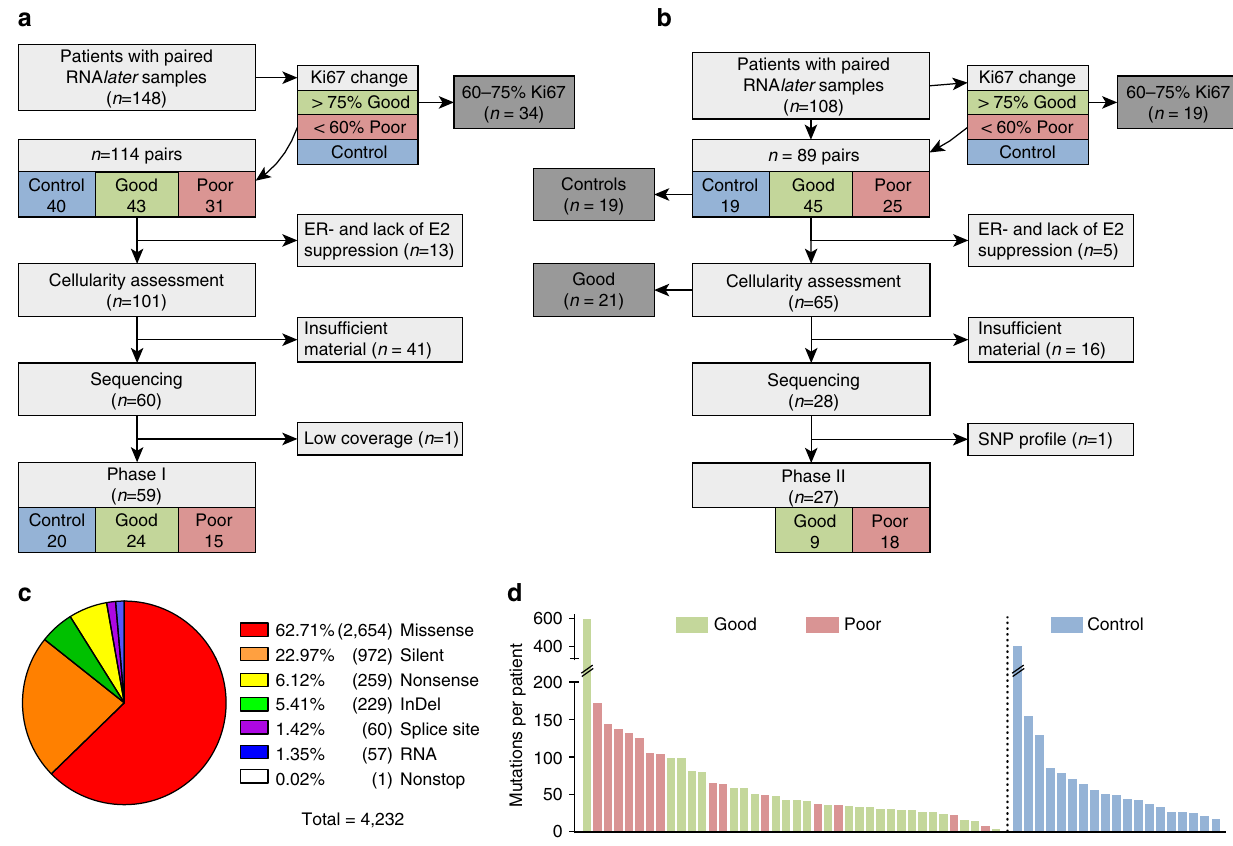
Figure 1 | CONSORT diagram and mutational landscape. Samples were selected in two phases using the same quality criteria. Samples in phase I ( a ) underwent whole-exome sequencing (WES) at low coverage for mutation detection followed by capture-probe sequencing for validation. Our goal was to select the same number of controls, good responders and poor responders, but due to the availability of samples and exclusion criteria, we were not able to identify 20 poor responders, instead 15 poor and 25 good responders entered the analysis. In phase II ( b ), samples that failed WES (not shown, see Supplementary Fig. 1) and samples from additional patients without prior WES were sequenced with the same capture-probe panel as in phase I. To balance the number of patients in the responder groups, preferentially poor responders were added. When samples from phase I and II combined, a total of 86 patients entered the downstream analysis, of which 77 are paired samples (see also Table 2). CONSORTdiagram is simplified; a more detailed version can be found in Supplementary Fig. 1. ( c ) Mutation type of all validated mutations in the exome of 59 patients from phase I and ( d ) number of mutations in each patient by responder groups. Identical mutations found in the baseline and surgery sample of the same patients appear once in this figure only. NATURE COMMUNICATIONS|7:13294|DOI: